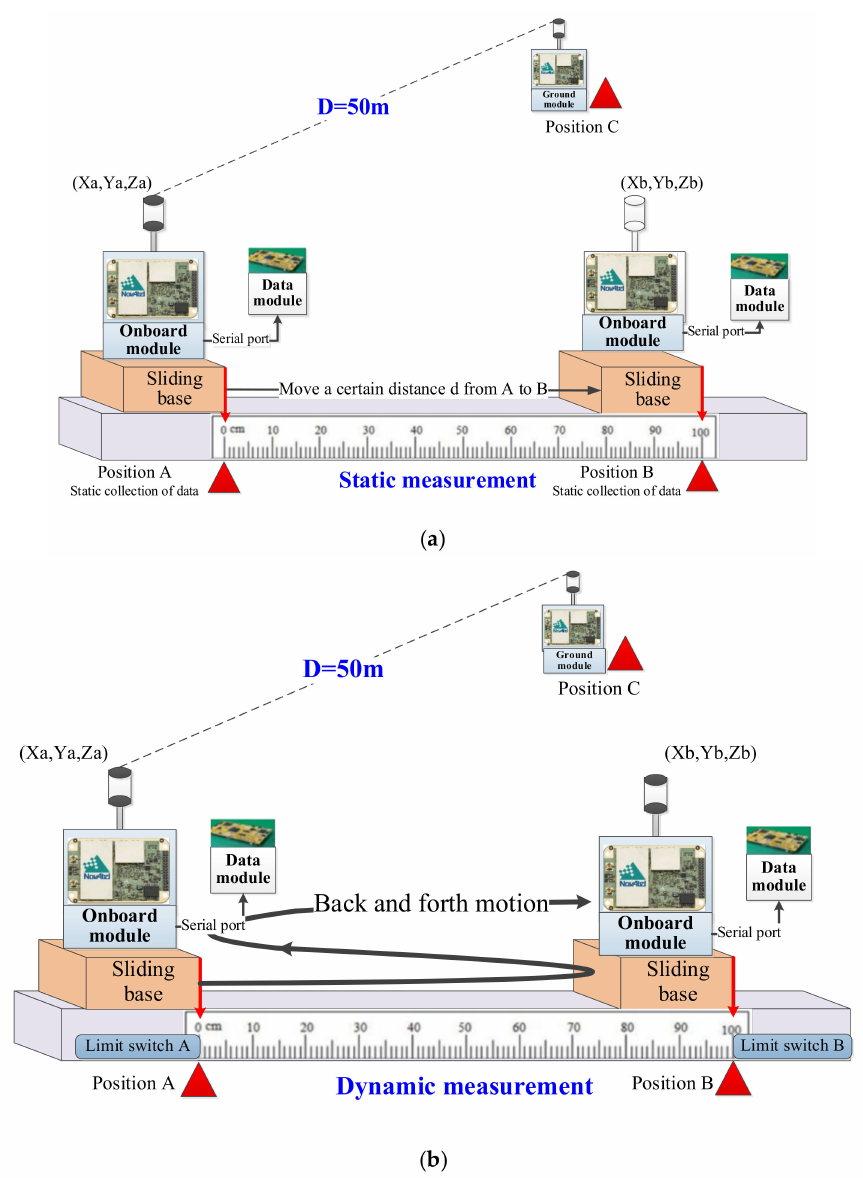
Figure 13. Static and dynamic positioning accuracy measurement solutions. ( a ) Static positioning accuracy measurement solutions. ( b ) Dynamic positioning accuracy measurement